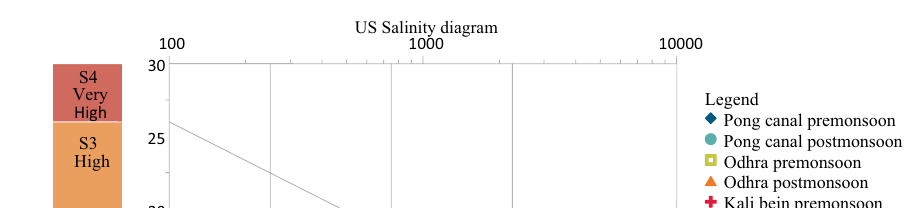
Fig. 2 Water classification according to SAR and EC values (USSL